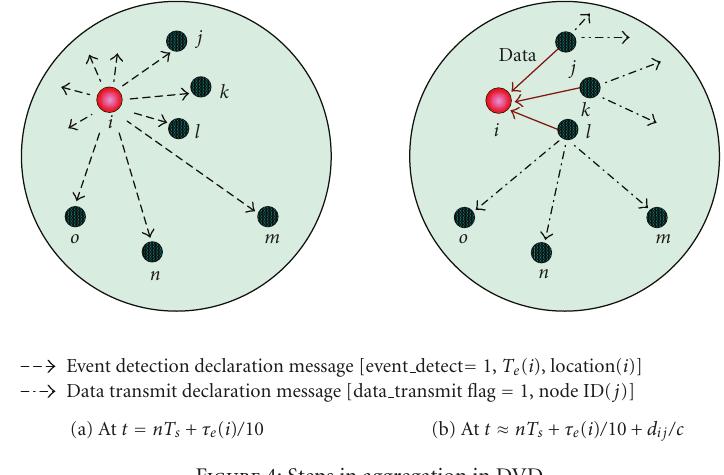
Figure 4: Steps in aggregation in DVD.